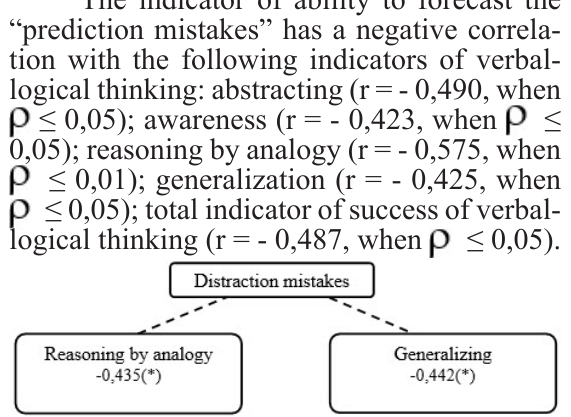
Figure 8. Correlation of mistakes of dis- traction and indicators of verbal-logical think- ing in children of preschool age